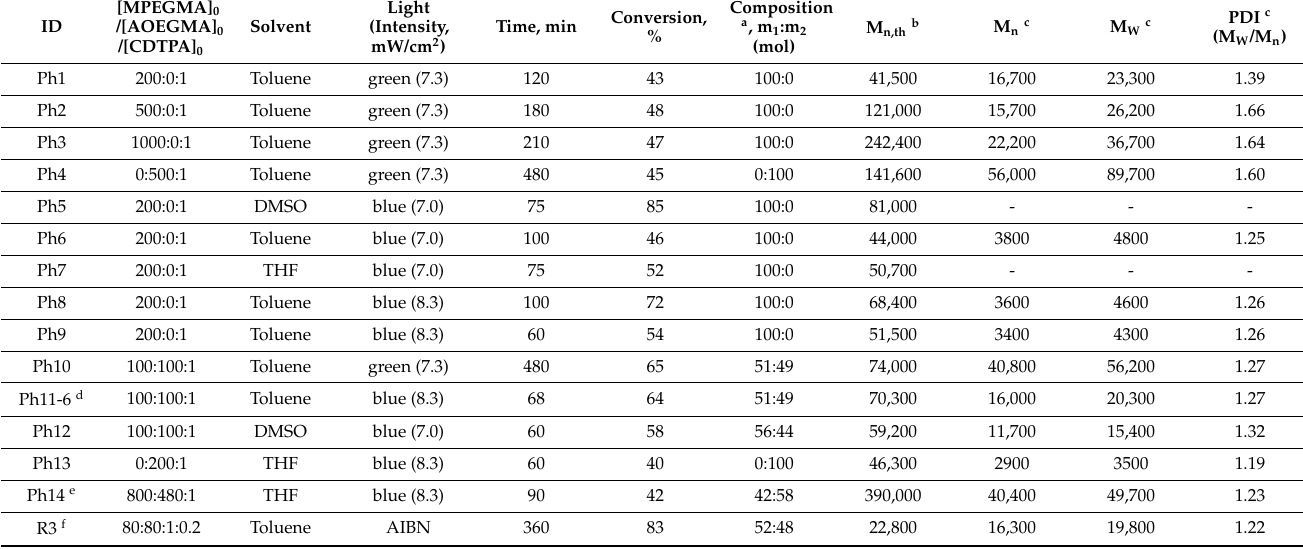
Table 1. Photoiniferter (co)polymerization of MPEGMA and AOEGMA.